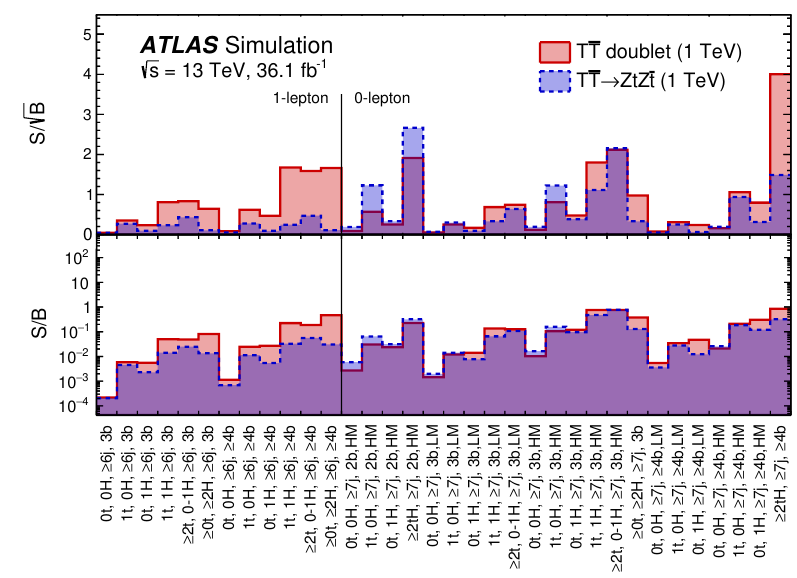
Figure 7. Signal-to-background ratio expressed as S= p B (resp. S=B ) in the top (resp. bottom) panel for each of the search regions. B and S stand for the total numbers of expected background and signal events in each region, respectively. For a 1 TeV T quark mass hypothesis, two branching ratio con(cid:12)gurations are displayed: the doublet model (red (cid:12)lled area) and (cid:12)lled